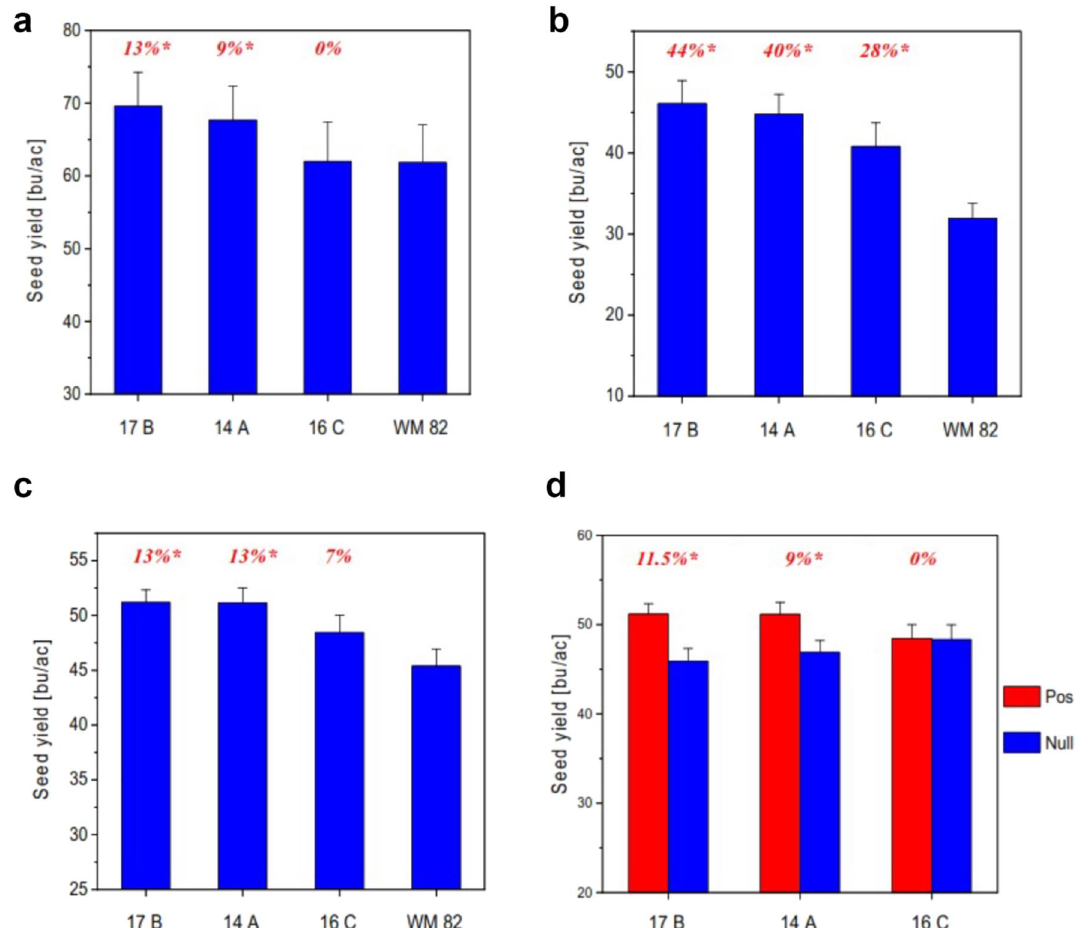
Figure 2. Seed yield of psNTP9 events and parental line Williams 82 (WM 82) trialed in 2016, 2017, and 2018. ( a ) Field trials were conducted at three different locations in the US—El Paso, Illinois; Henderson, Kentucky; and Atlanta, Indiana. Seed yield performance and analysis of psNTP9 events at each of the individual sites can be found in supplemental data. Combined site analysis over the three trials determined 5.25 bushels per acre as the value of 5% least squared difference (LSD 0.05 ) for mean separations. Asterisk symbol (*) next to yield delta (%) inside the figure indicates significant yield difference from parental line WM 82 at p = 0.05. All data are presented as mean of eight plot replicates over three individual sites ± standard error (SE). ( b ) Seed yield of psNTP9 events and parental line trialed in 2017. The field trials were implemented during the counter-season seed increase at three locations in Puerto Rico. Seed yield performance and analysis of psNTP9 events at each of the individual sites can be found from supplemental data. Combined site analysis of seed yield over the three trials determined 3.91 bushels per acre as LSD 0.05 value for mean separations. Asterisk symbol (*) next to yield delta (%) values inside the figure indicates significant yield difference from parental line WM 82 at p = 0.05. All data are presented as mean of fifteen plot replicates over three individual sites ± SE. ( c ) Seed yield of psNTP9 events and parental line trialed in 2018. The field trials were conducted at three different production regions in the US—Lawrence, Kentucky; Smithville, Missouri and Troy, Ohio. Seed yield performance and analysis of psNTP9 events at each of the individual sites can be found from supplemental data. Combined site analysis of seed yield over the three trials determined 3.30 bushels per acre as LSD 0.05 value for mean separations. All data are presented as mean of twelve plot replicates over three individual sites ± SE. ( d ) Seed yield of psNTP9 and sibling nulls trialed in 2018. The field trials were conducted at three different production regions in the US— Lawrence, Kentucky; Smithville, Missouri and Troy, Ohio. Combined site analysis of seed yield over the three trials determined 3.30 bushels per acre as LSD 0.05 value for mean separations. Asterisk symbol (*) next to yield delta (%) inside the figure indicates significant yield difference from corresponding sibling null at p = 0.05. All data are presented as mean of twelve plot replicates over three individual sites ±